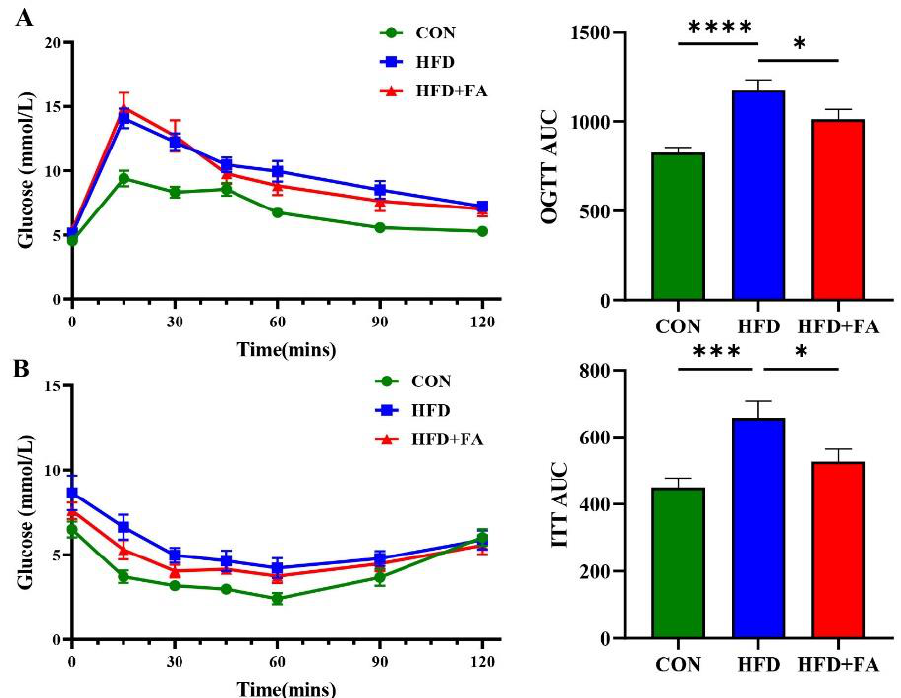
Figure 3. FA improves insulin tolerance and glucose tolerance. ( A ) Oral glucose tolerance test (OGTT) and area under the curve (OGTT-AUC) of mice from three groups, CON, HFD, and HFD+FA. ( n = 10). ( B ) Insulin tolerance test tests (ITT) and area under the curve (ITT-AUC) of mice from the three groups, CON, HFD, and HFD+FA. ( n = 10). Data are shown as mean ± SEM. * p < 0.05, *** p < 0.001, **** p < 0.0001.